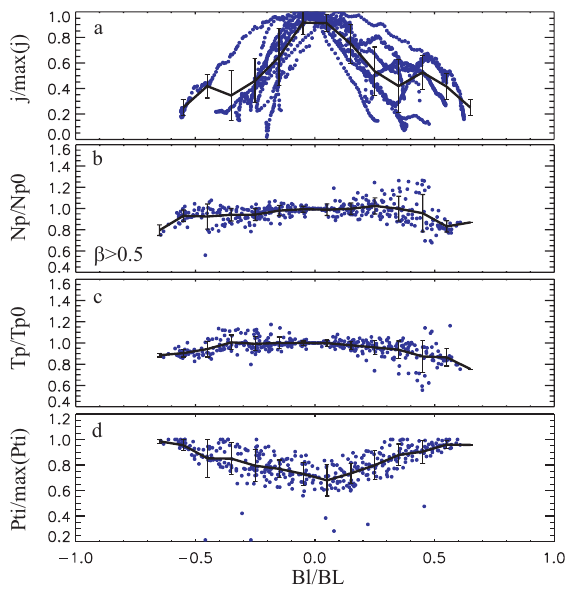
Fig. 5. Profiles of the current density (a) , proton number density, normalized by the value N 0 = N p (B l = 0 ) (b) , and proton tempera- ture (c) normalized by T 0 = T p (B l = 0 ) , and the sum of magnetic and ion pressures ( Pt i ) (d) , normalized by their maximum value, versus normalized main magnetic field B l /B L for class I current